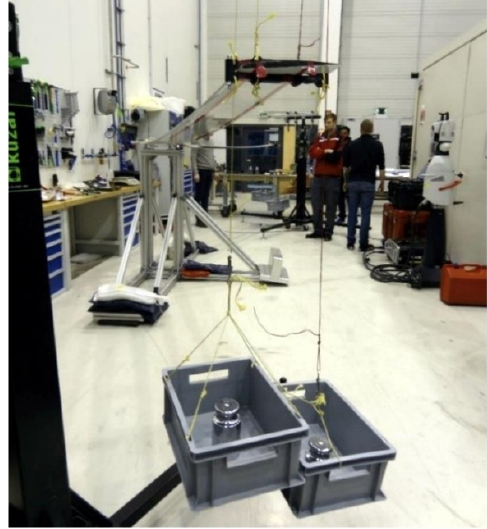
Figure 10. Static test setup—load application.